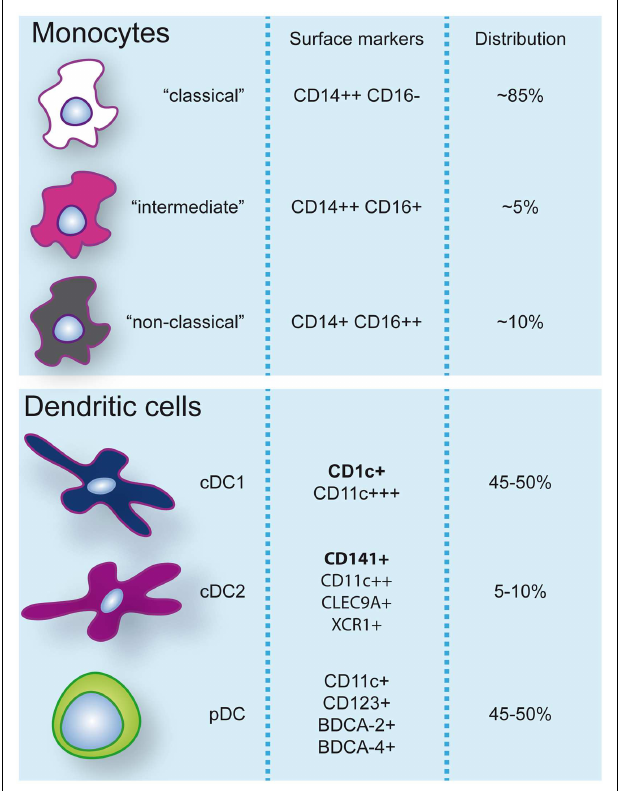
FIGURE 1 | Monocyte and dendritic cell populations in human peripheral blood during steady-state conditions . Expression of markers commonly used to identify and discern these populations are indicated. Additionally, frequencies (%) of monocyte subsets within the monocyte pool and dendritic cells within the dendritic cell pool are